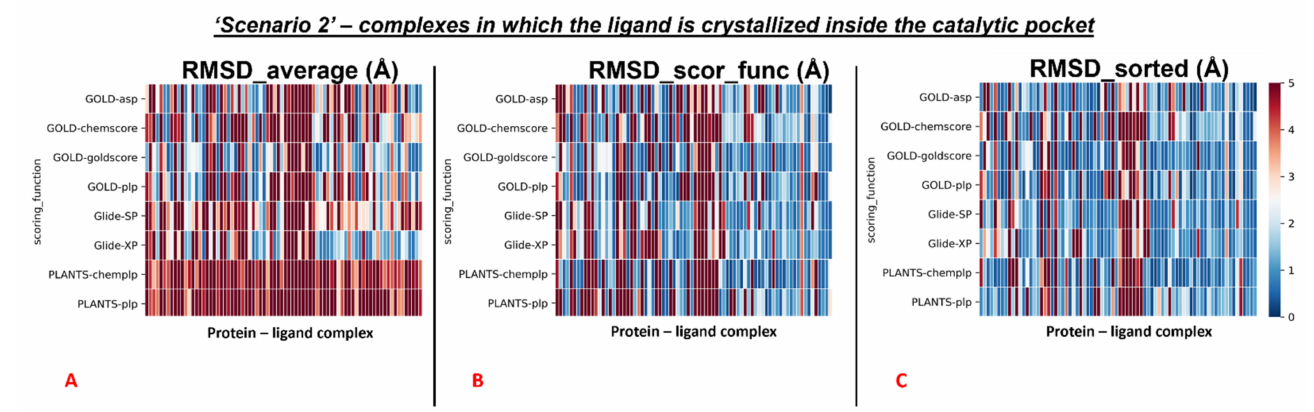
Figure 7. Colormaps represent the results of the self-docking experiments just for the ligands crystallized inside the orthosteric pocket in the situation in which the crystallographic water molecules at 5 Å or nearer to the ligand itself are taken into account during the docking runs. ( A ) Results coming from the average of the RMSDs of all the poses for each docking run. ( B ) Results derived just from the RMSD between the crystallographic ligand coordinates and the once of the pose classified as the best from the scoring function. ( C ) Results of the self-docking experiments if just the pose showing the best RMSD value between its coordinates and the crystallographic ones are retained. The x -axis lists all the different protein–ligand complexes, which are plotted against the different pairs docking program-scoring function used for this study, reported in the y -axis.